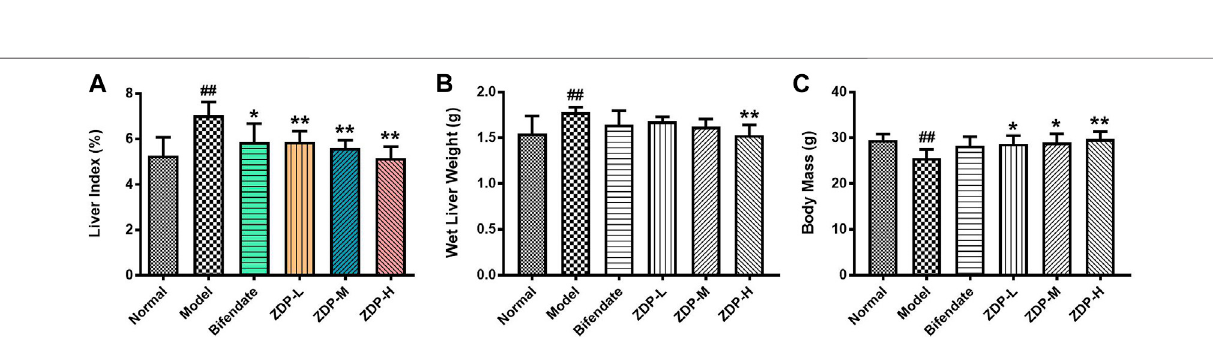
Frontiers in Pharmacology |